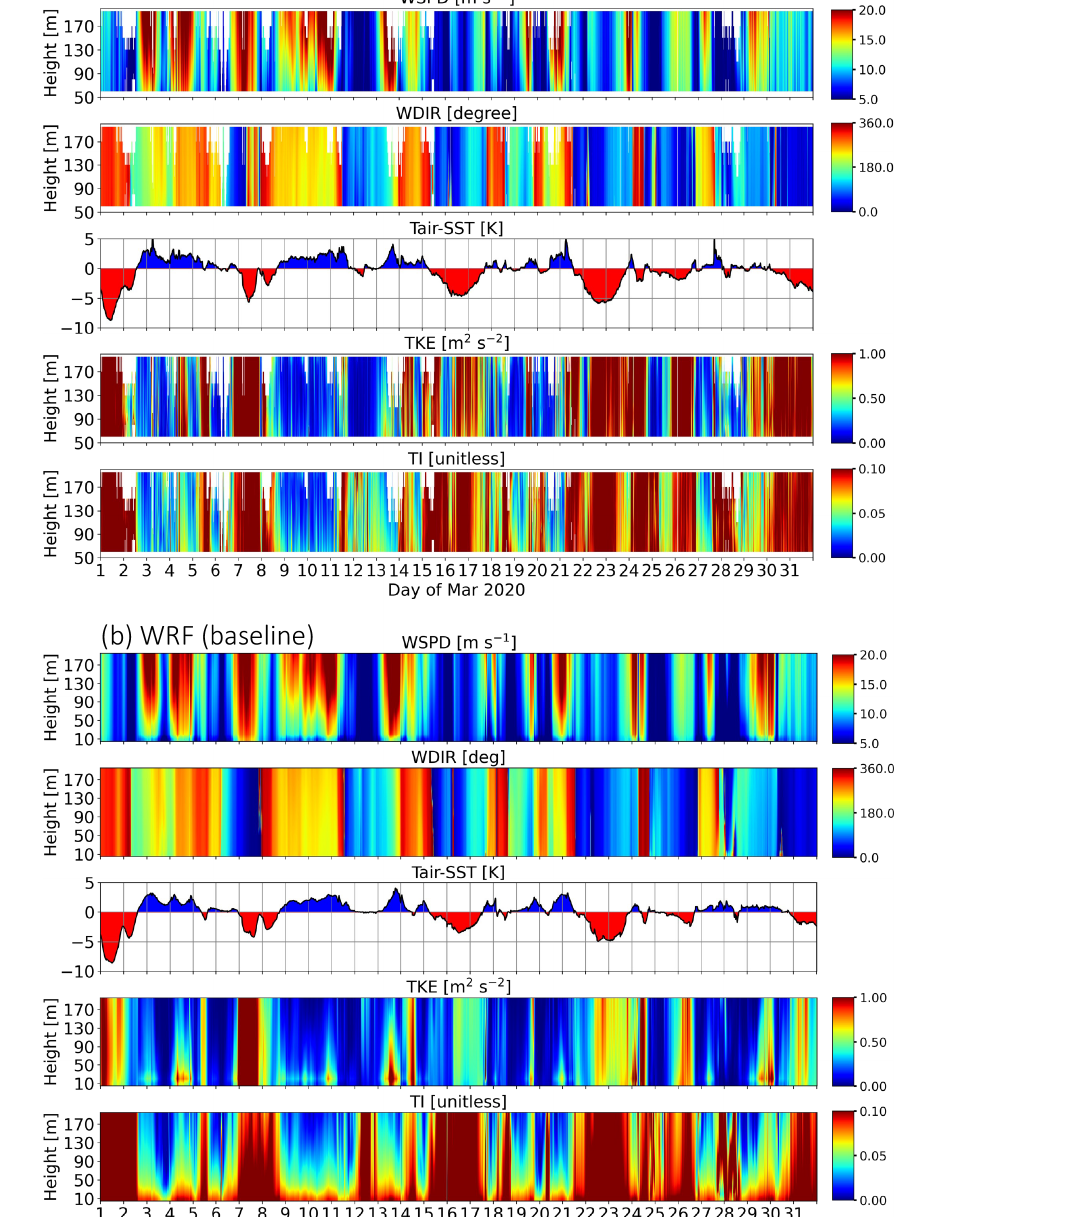
Figure 3. Time–height comparison of wind speed (WSPD), wind direction (WDIR), air–sea temperature gradient ( T air − SST), turbulence kinetic energy (TKE), and sub-grid turbulence intensity (TI). Results for lidar and buoy observations and baseline simulation during the period of March are given in (a) and (b) ,